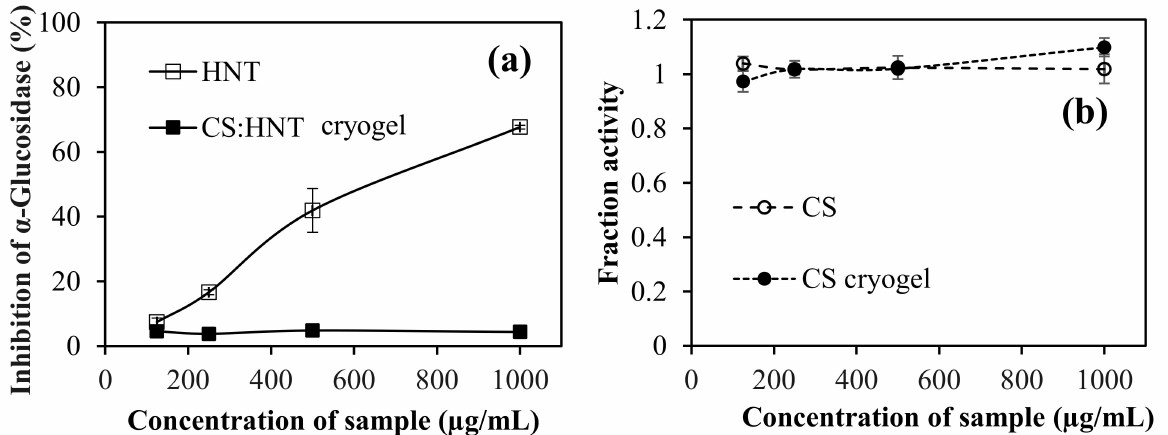
Figure 8. ( a ) Inhibition of α -glucosidase percentage of HNT and CS:HNT cryogel, and ( b ) α -glucosidase fraction activity of CS and CS